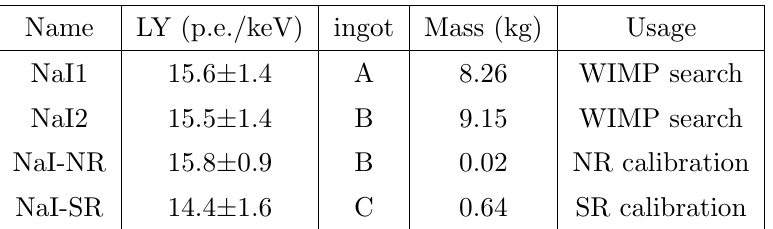
Table 2 . The Light Yield (LY) and powder of crystals used in WIMP search data and calibrations.